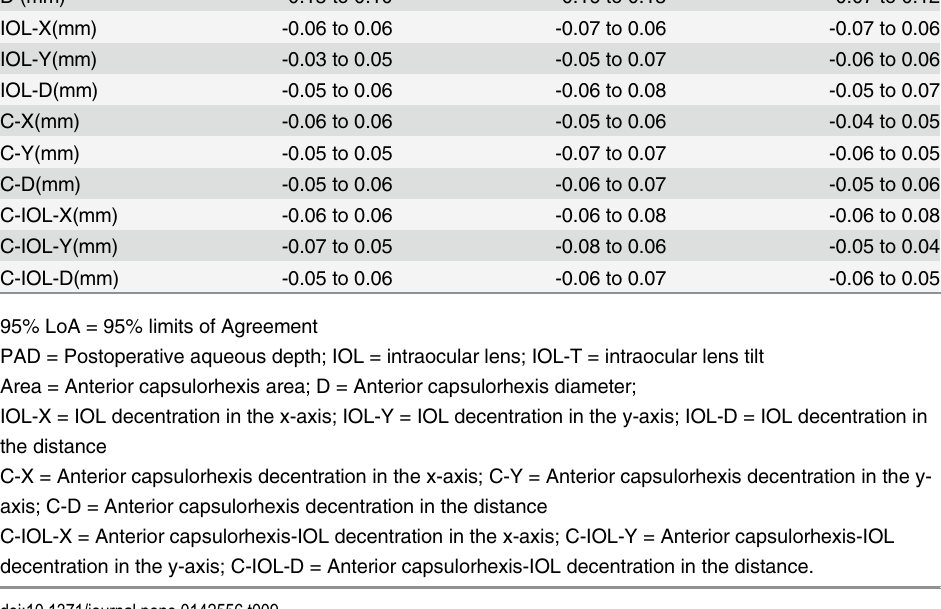
the distance C-X = Anterior capsulorhexis decentration in the x-axis; C-Y = Anterior capsulorhexis decentration in the y- axis; C-D = Anterior capsulorhexis decentration in the